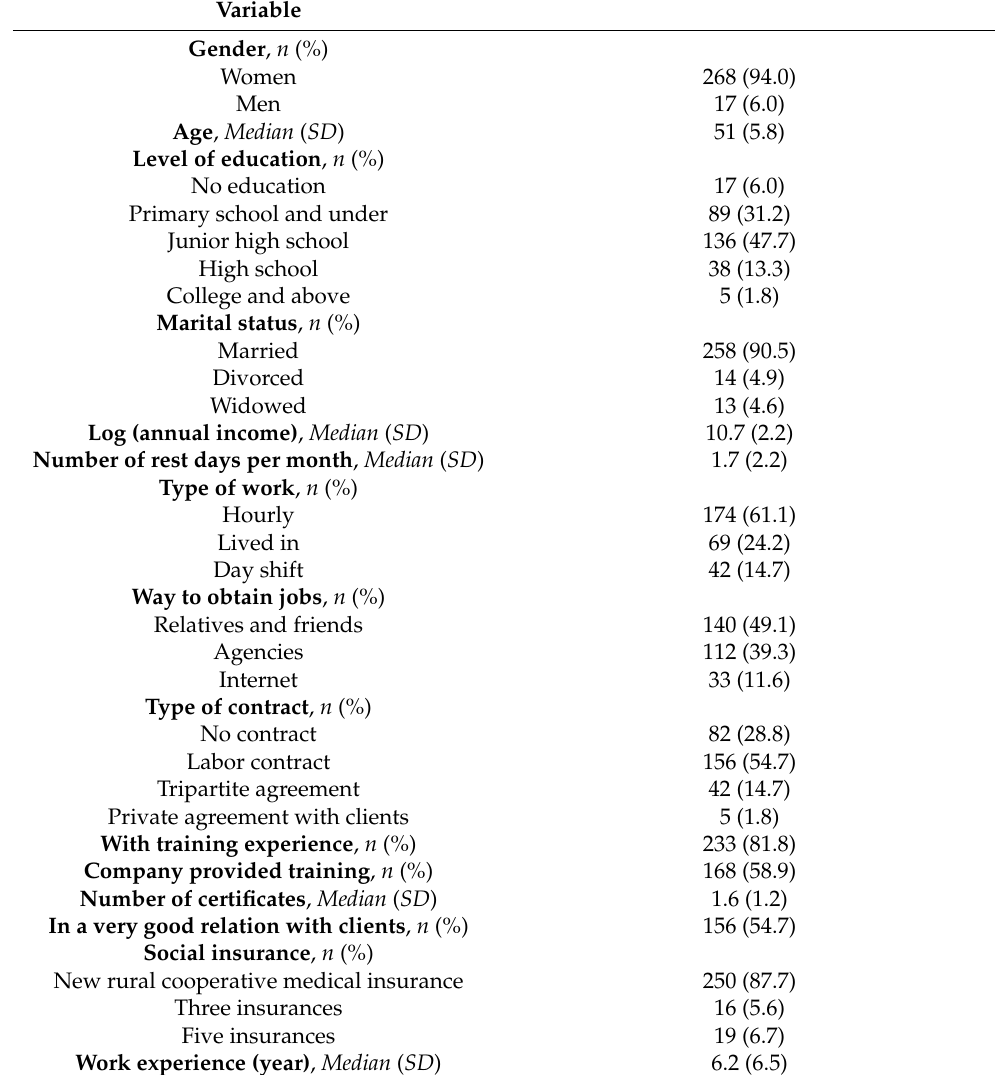
Table 1. Personal characteristics and employment-related